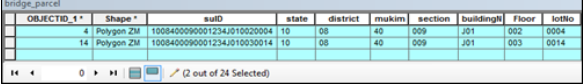
Figure 7. The result of query in bridge_parcel table